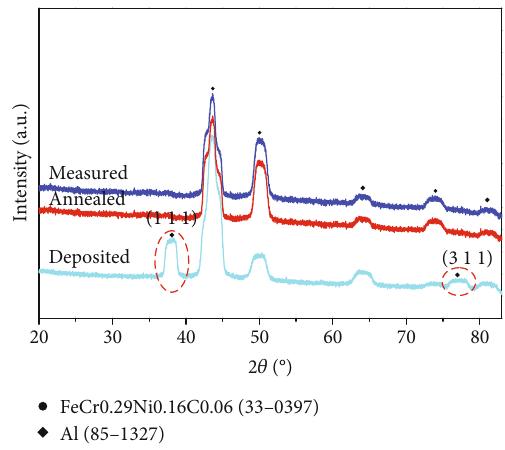
Figure 3: GIXRD spectra of the deposited, annealed and measured Al/Al O composite 2 3